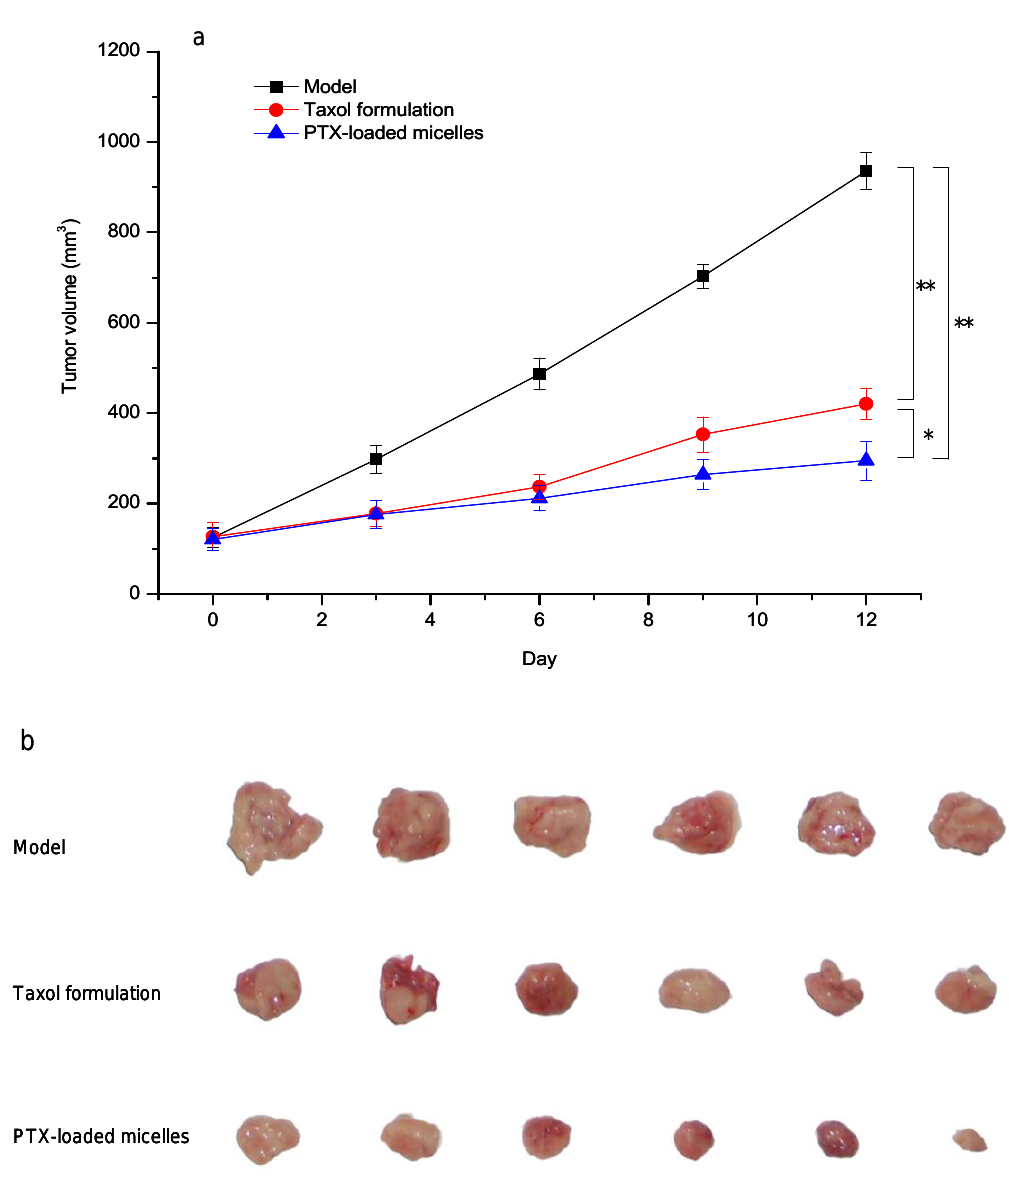
Figure 9. In vivo antitumor activity of PTX-loaded mPEG-CS(SH)-CHO micelles: ( a ) tumor volume growth curves after various treatments (* p < 0.05; ** p < 0.01); ( b ) photos of tumors excised from different groups.